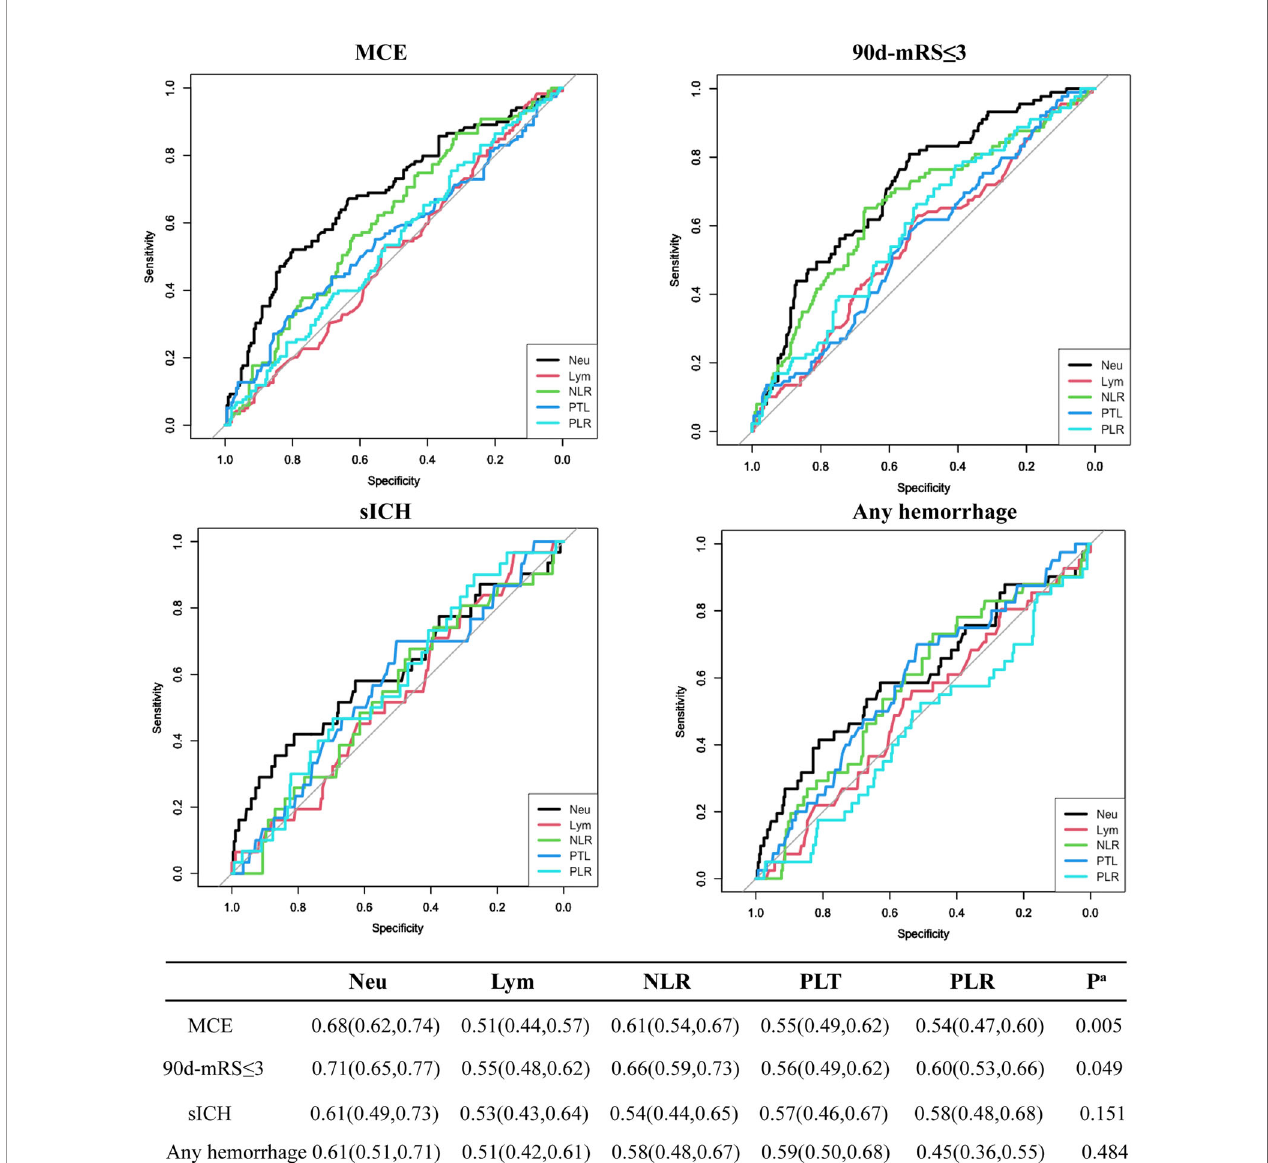
FIGURE 1 | Predictive values of neutrophil count (Neu), leukocyte count (Lym), platelet count (PTL), PLR, and NLR for 4 endpoints including MCE, long-term favorable outcome, sICH, and any